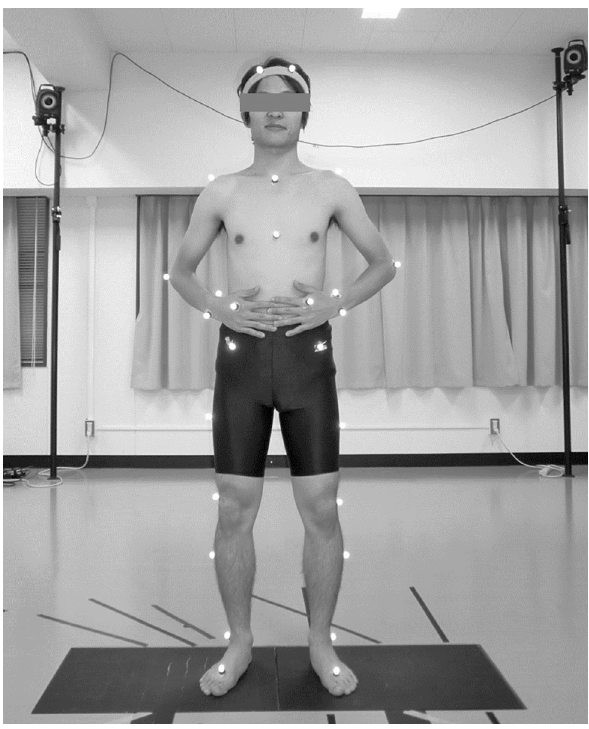
Fig 1. The starting position of motion task. The reflective markers were attached to specific placementon the subjects.